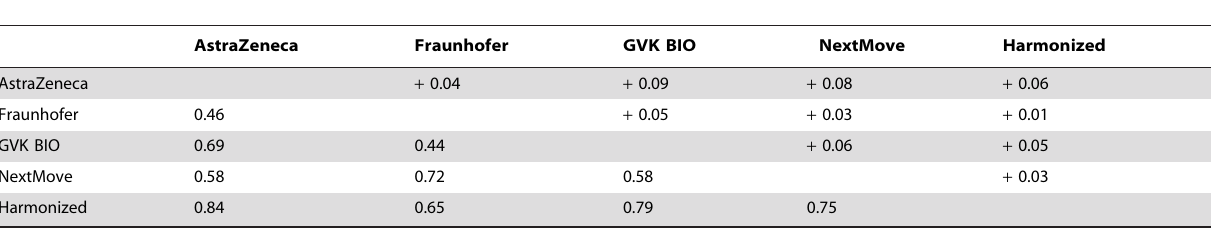
Table 5. Inter-annotator agreement after ambiguity resolution.